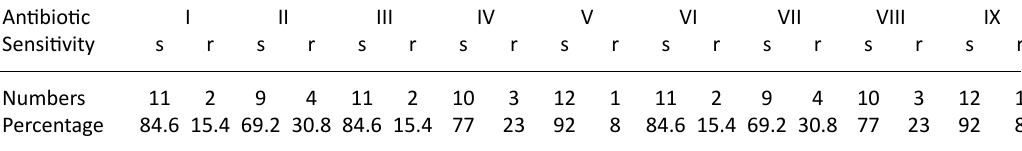
Table 2. Antibiotic sensitivity of isolates with less diversified plasmid DNA (13 samples)